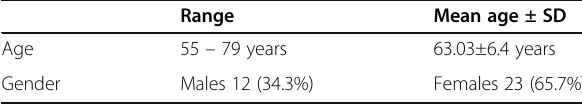
Table 1 Demographic distribution of the patients